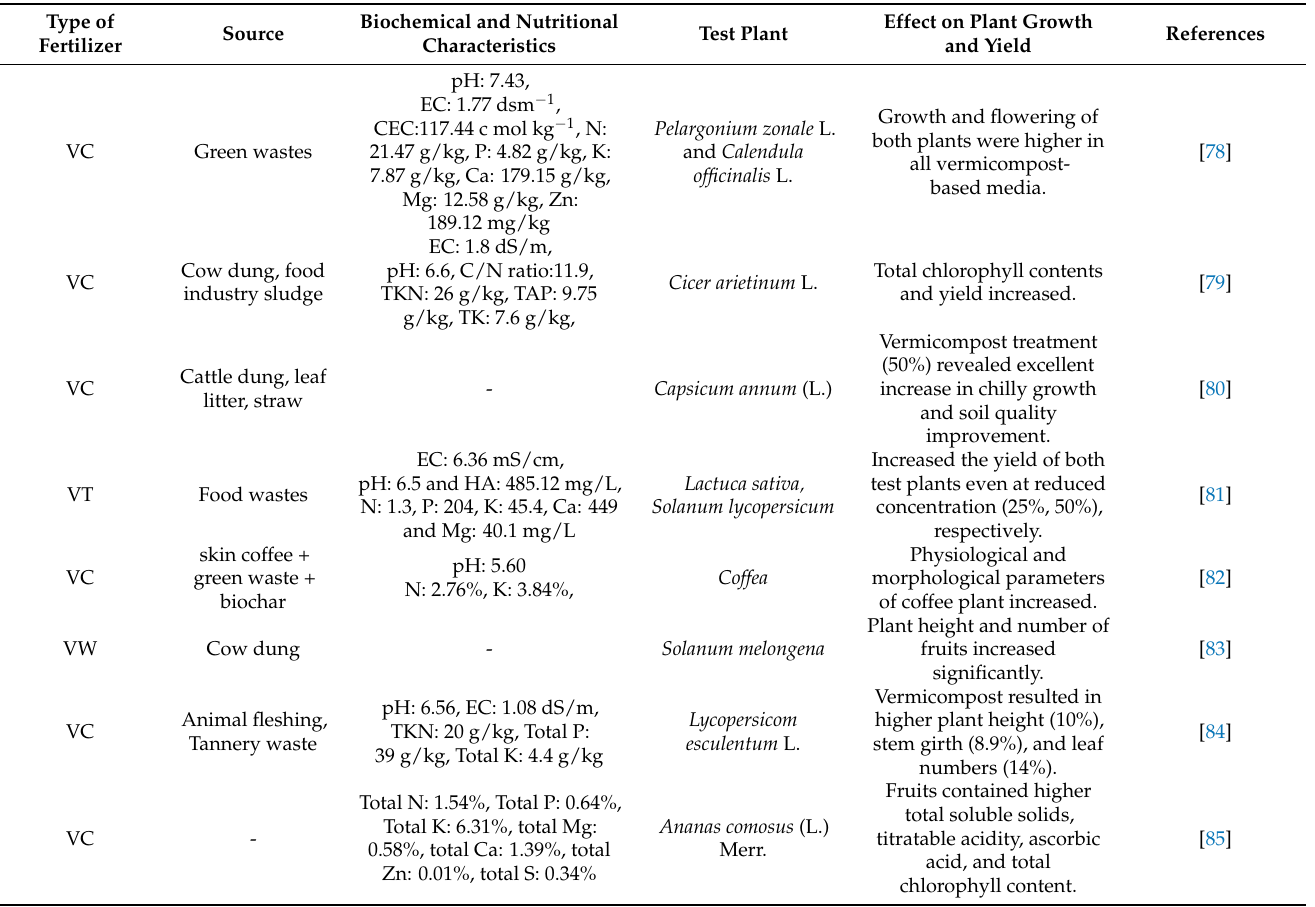
Table 1. Impact of vermicompost and its derivatives on plant growth and